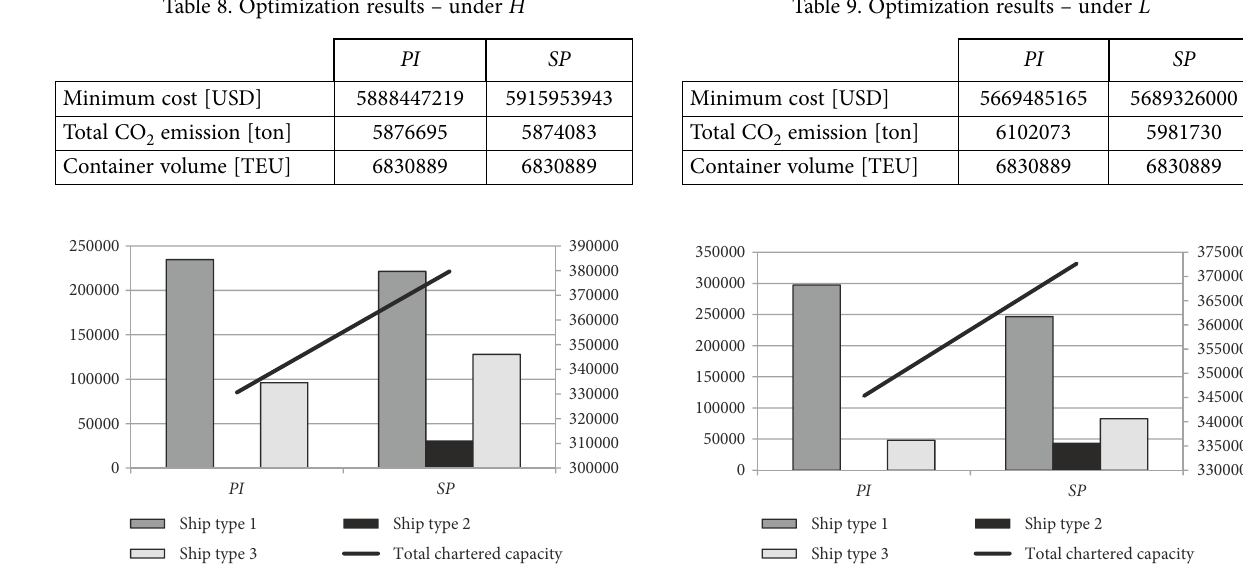
Figure 3. Chartering capacity comparison – under H Figure 4. Chartering capacity comparison – under L